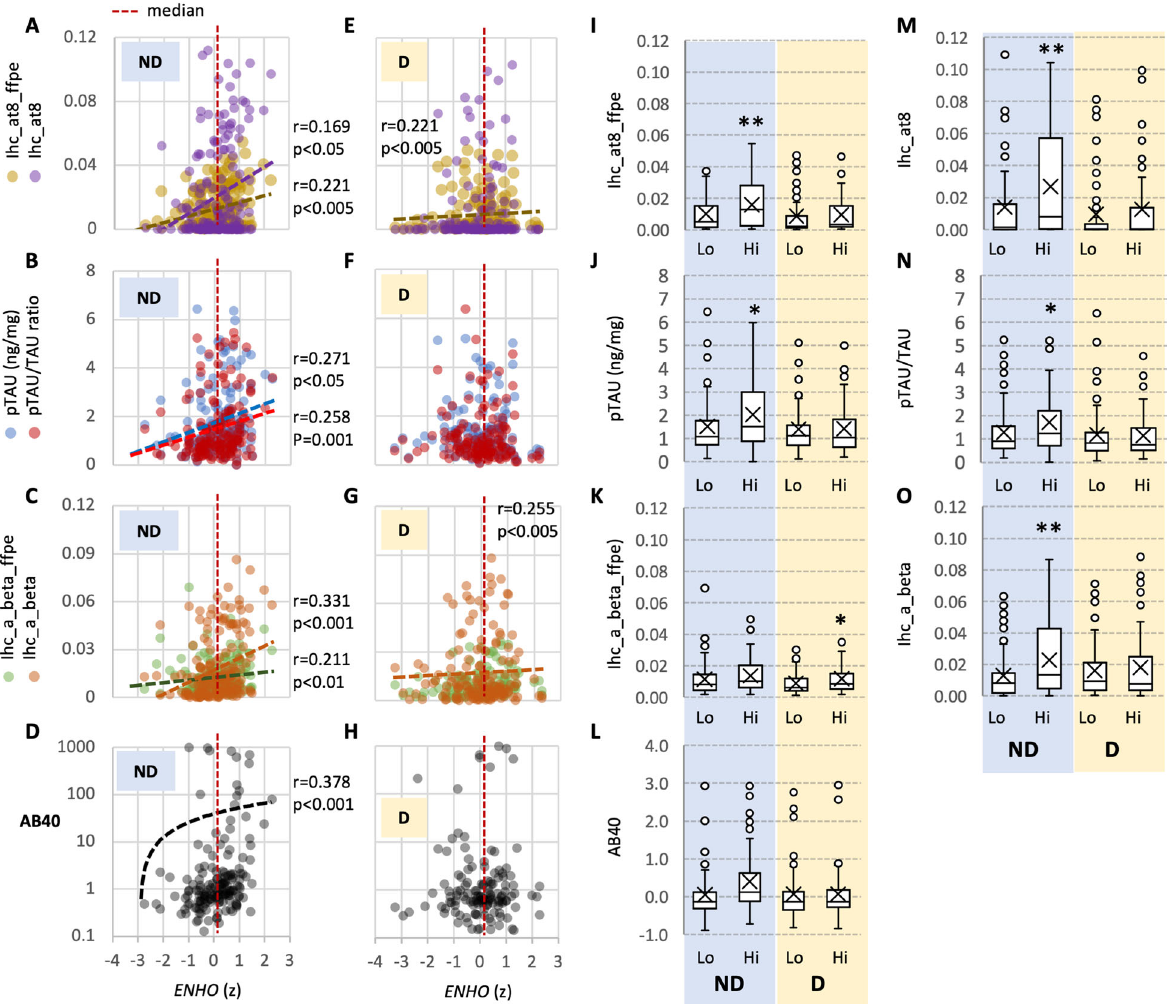
Fig. 3 Scatterplots showing relationships between relative ENHO expression ( x -axis) and protein markers of aging-related neuropathology. Data are shown as scatterplots for samples from study participants with no dementia ( A – D ) or with dementia ( E – H ). The box-and-whisker plots shown in ( I - O ) show the averaged data for D and ND samples split into subgroups (Lo, Hi). ‘ Lo ’ indicates data from samples with ENHO values below the median (76 samples for D, 90 samples for ND), while ‘ Hi ’ indicates data from samples with ENHO values above the median (76 samples for D, 90 samples for ND). The markers shown reading top to bottom are AT8 (tau phosphorylation of Ser202 and Thr205), TAU (total phosphorylated tau, and ratio of phosphorylated to non-phosphorylated tau), A β , and AB40 (Ab40). Correlation coef fi cients are shown where associations are signi fi cant ( p < 0.05). For AT8 and Ab staining, data are shown from fresh frozen (ffpe) or paraf fi n-embedded sections. The data were subdivided into two groups (below or above the median) after being ranked by ENHO expression. The median is shown as the red dashed line in the scatterplots shown in ( A – H ). Ranking occurred for all participants (All), or for subgroups separated by dementia status (ND, no dementia; D, dementia). Signi fi cantly different from low dementia status, ** p < 0.01; * p <